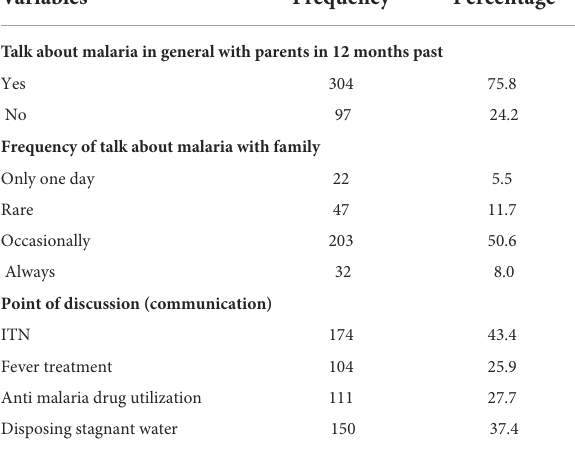
TABLE 3 Parent student communication and family readiness in Jimma zone, Ethiopia